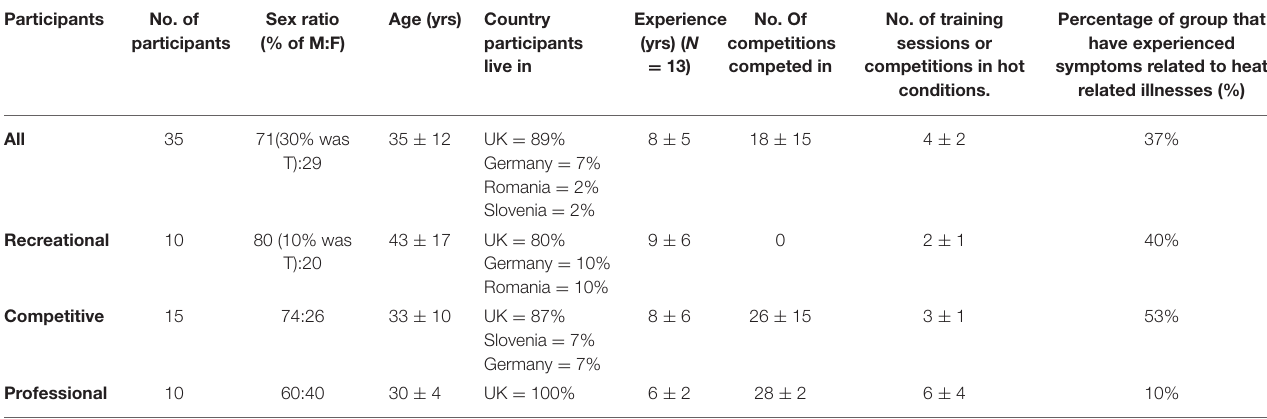
TABLE 2 | Participant characteristics including number of participants, sex ratio (M:F), country participants live in, years of experience (yrs), number of competitions competed in, number of training sessions in hot conditions, percentage of group that have experienced symptoms related to heat related illnesses (%).